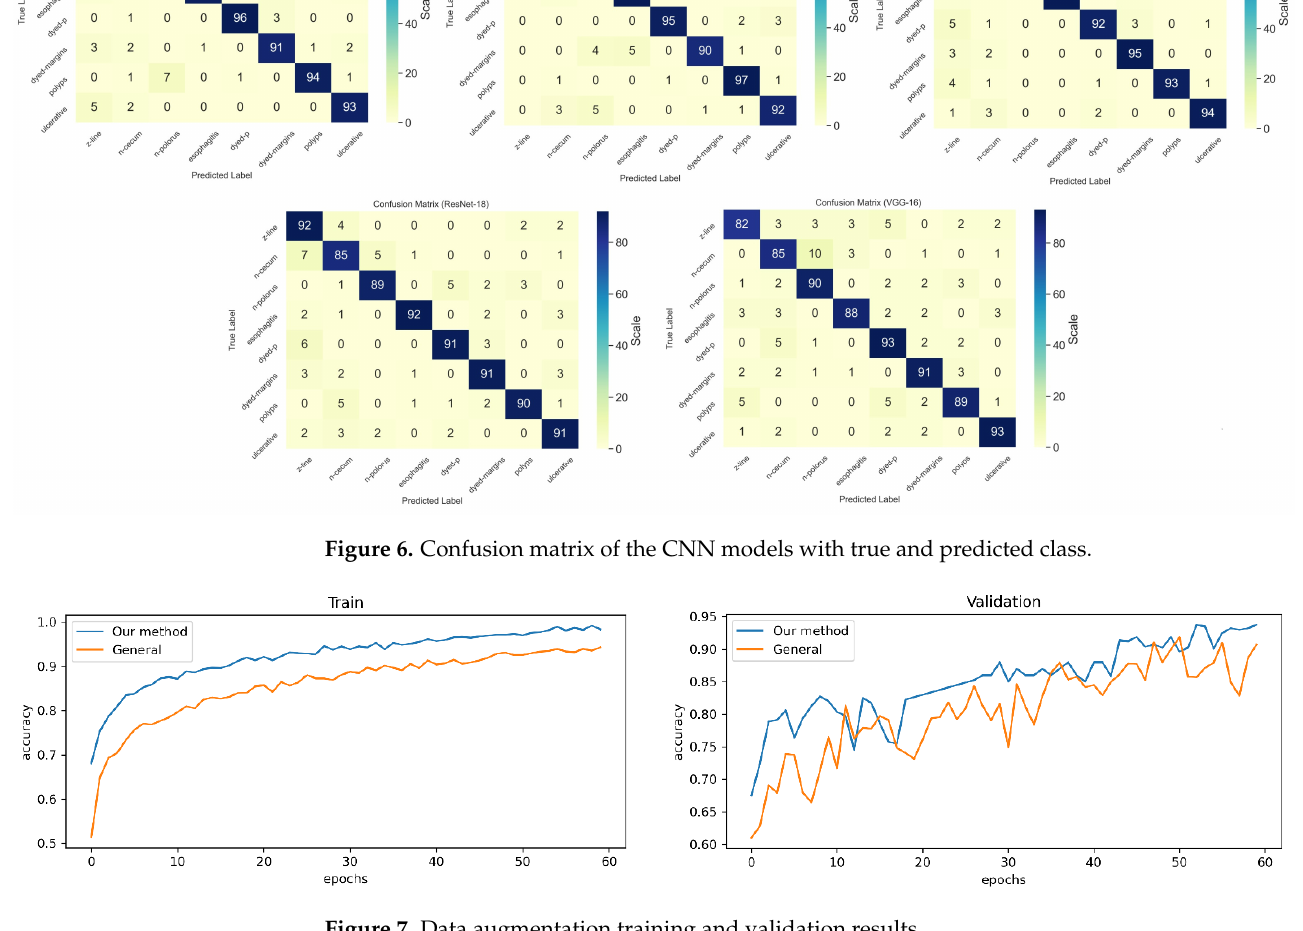
Table 2. Detailed information on the training results of the CNN models.